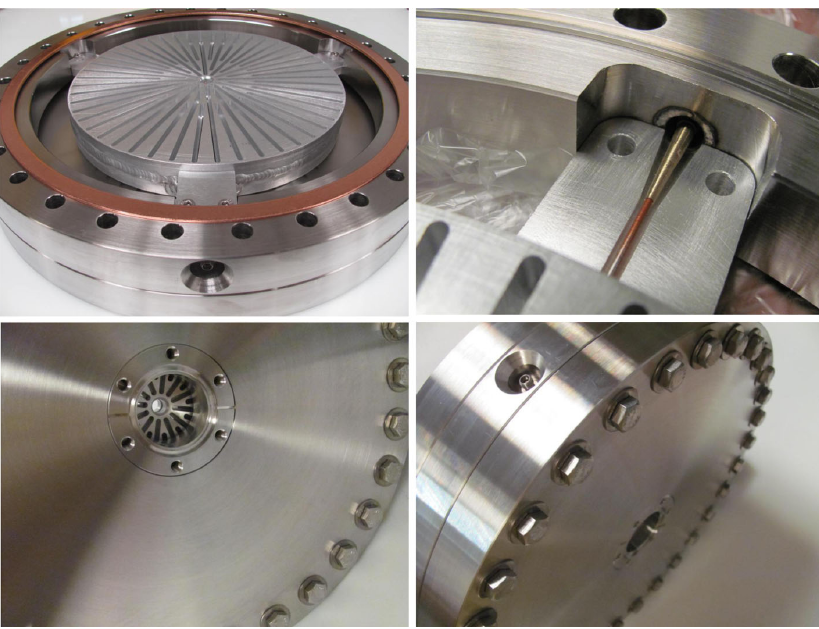
FIG. 2. The cavity bunch-length monitor during